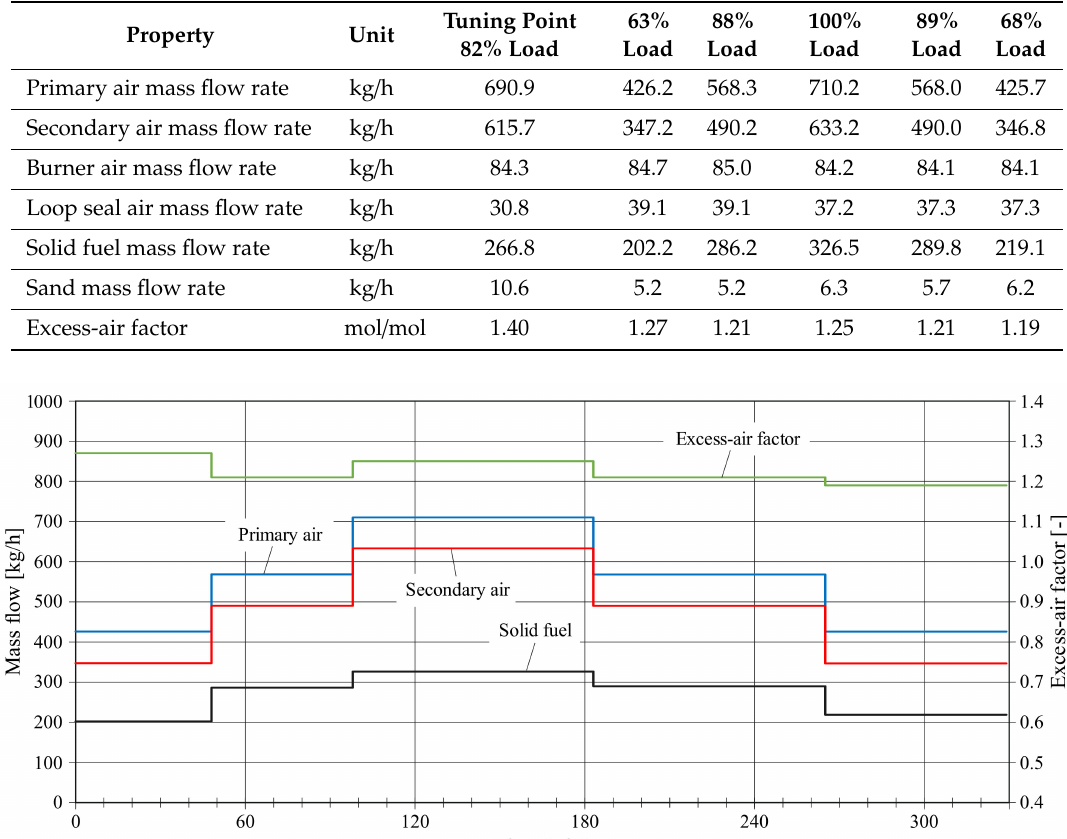
Table 5. Test conditions at steady-state and part-loads.